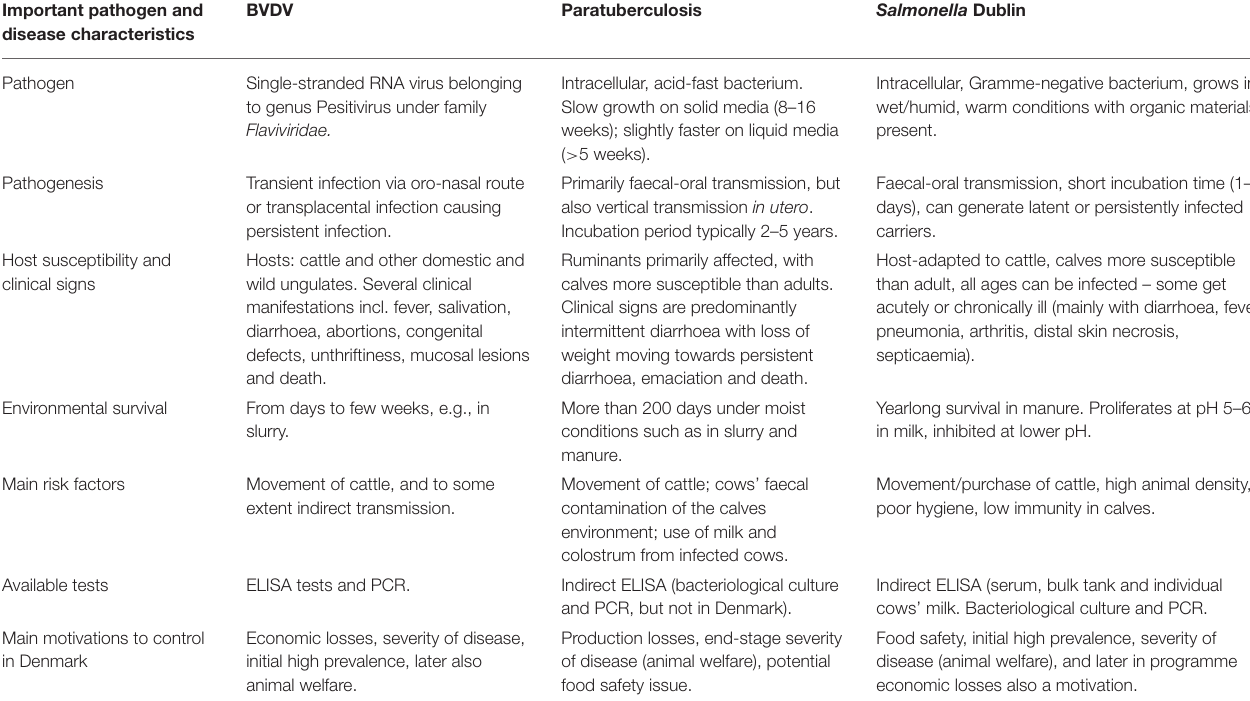
TABLE 1 | Comparative summary with non-exhaustive information about important characteristics of three infectious diseases under surveillance and/or control in Danish cattle during up until June 30,